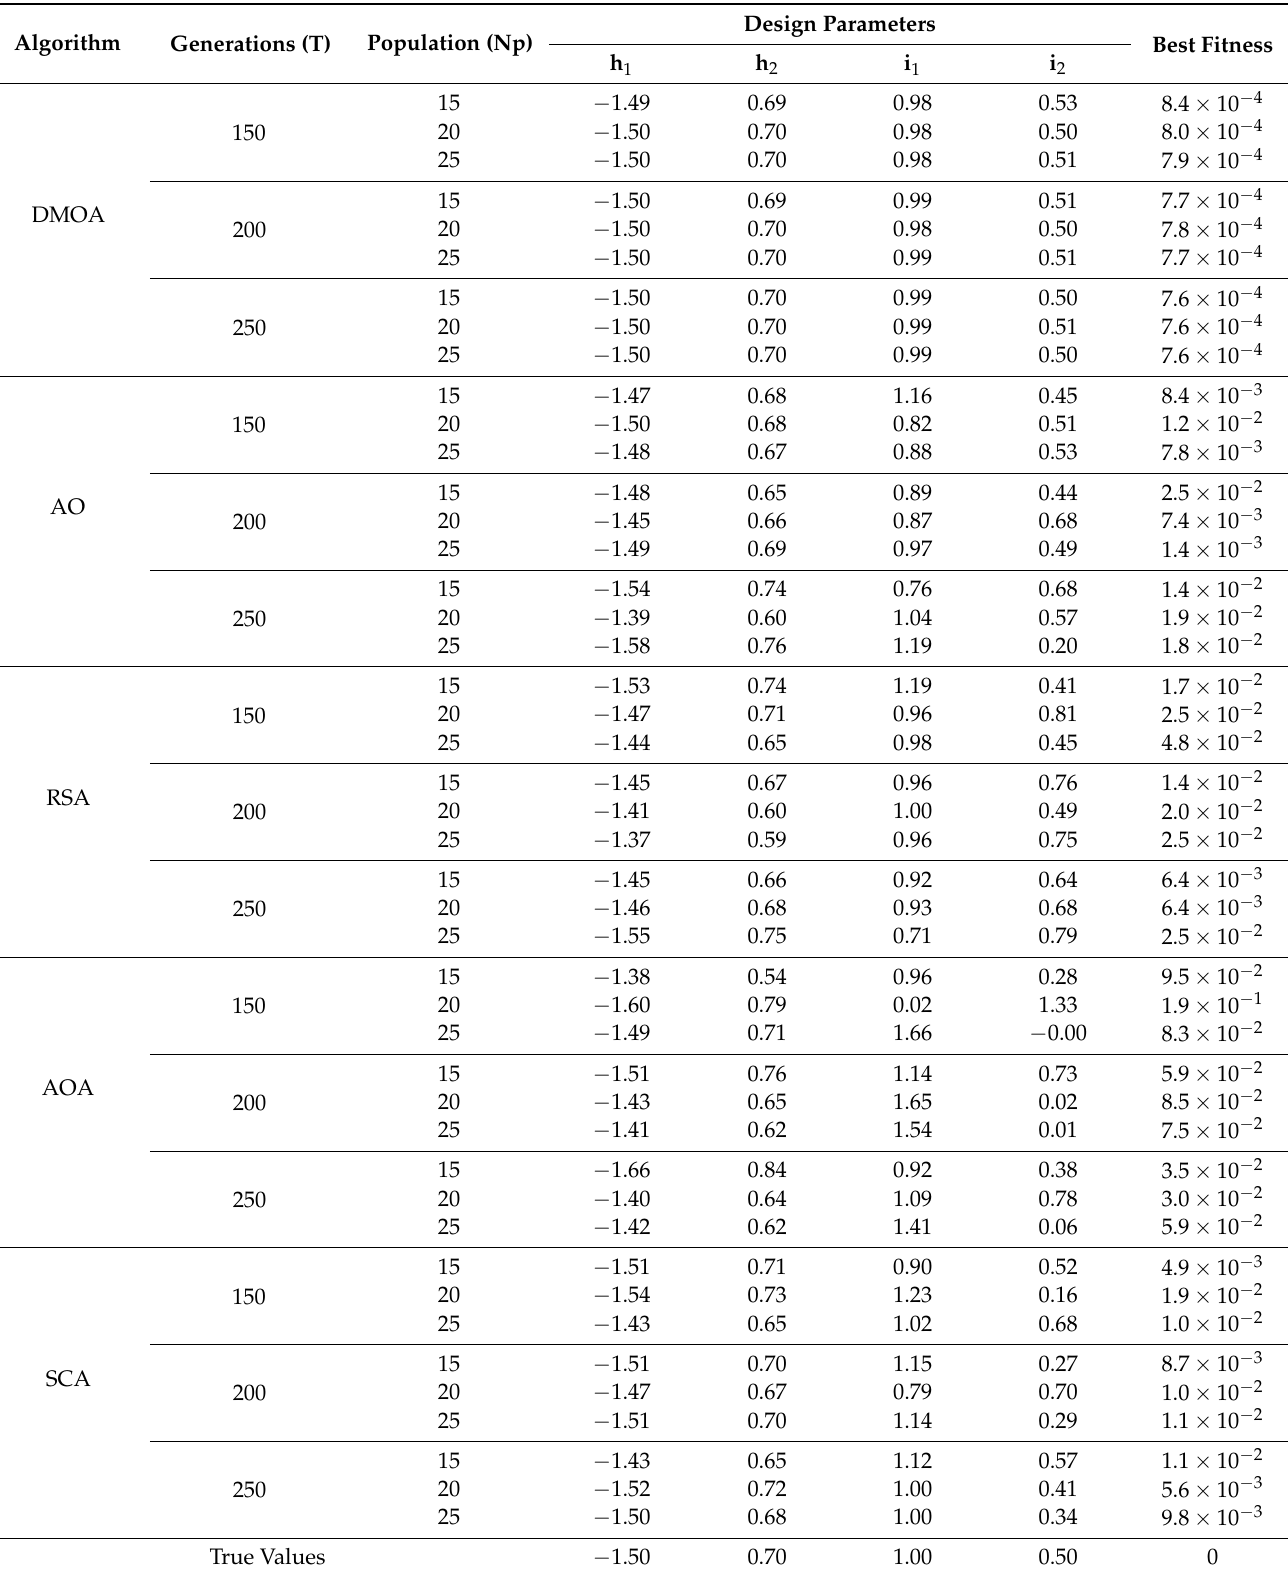
Table 7. Comparison of the DMOA with the AO, RSA, AOA and SCA against true values for the ARX model at 0.03 noise